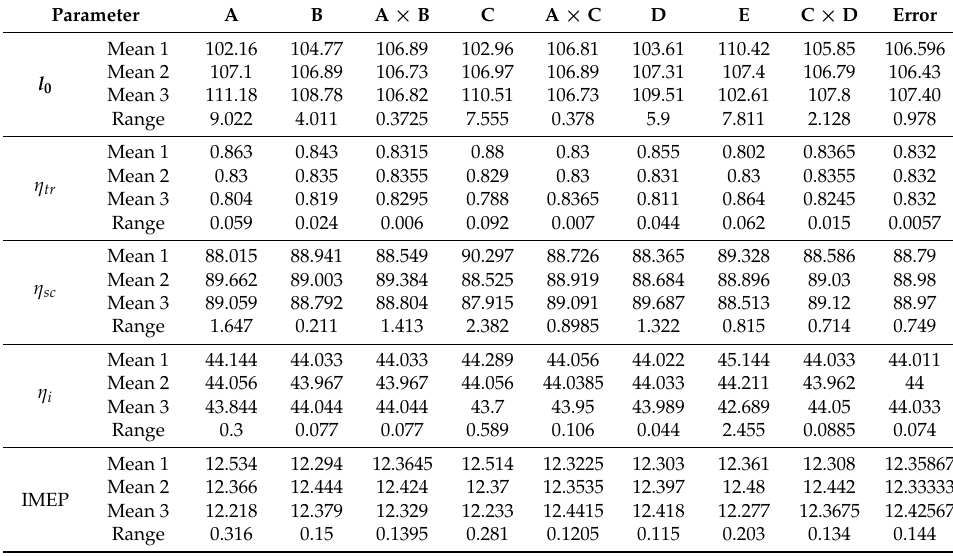
Table 4. Range analysis.